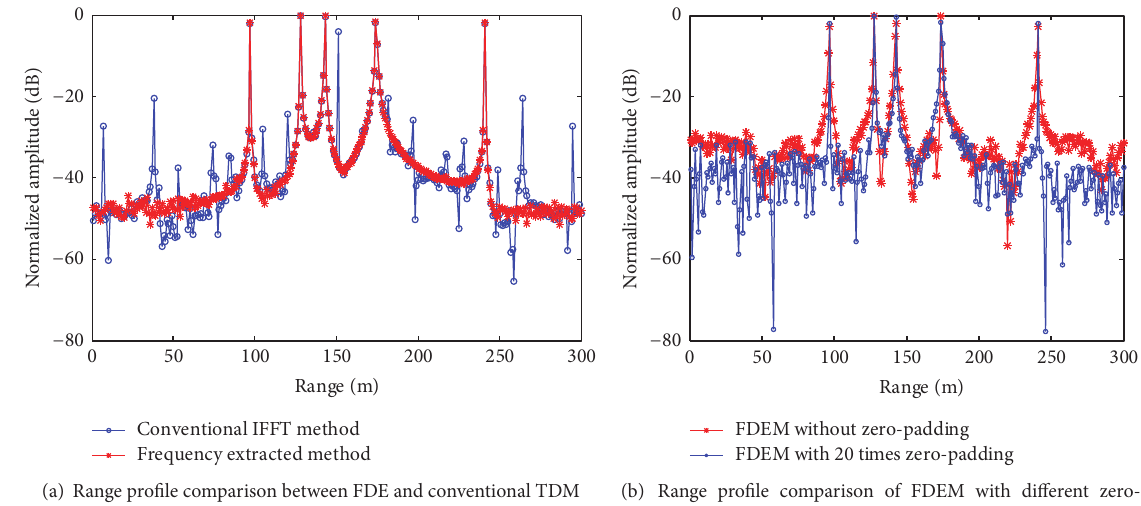
Figure 4: Range profile obtained by FDEM, SNR = −